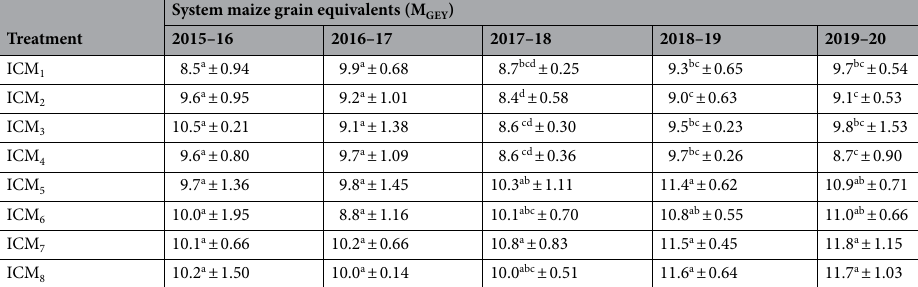
Table 2. Five years’ trend of system productivity (Mg ha −1 ) (± S.D.) in terms of maize grain equivalent yield (M GEY ) of maize-wheat rotation under different ICM modules. Means followed by a similar lowercase letters within a column are not significantly different at p < 0.05 according to Tukey’s HSD test. # ICM 1&2 = conventional flatbed maize & wheat (CT FB ); ICM 3&4 = conventional raised bed maize & wheat (CT RB ); ICM 5&6 = zero-till (ZT) flatbed maize with wheat residue at ~ 3 Mg ha −1 (ZT M + W R ) & ZT wheat with maize residue at ~ 5 Mg ha −1 (ZT W + M R ), and ICM 7&8 = ZT raised bed maize with wheat residue (ZT RB + W R )